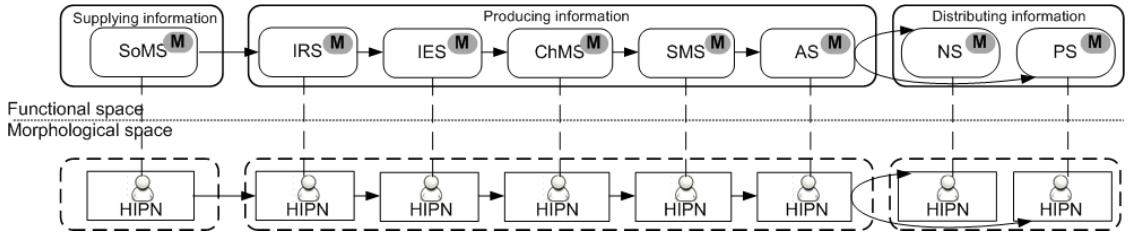
Figure 8. Single-mode logistics as a specific case of a multimode information logistics; HIPNs should be considered here as different information processing roles [7] that can be performed by a random number of